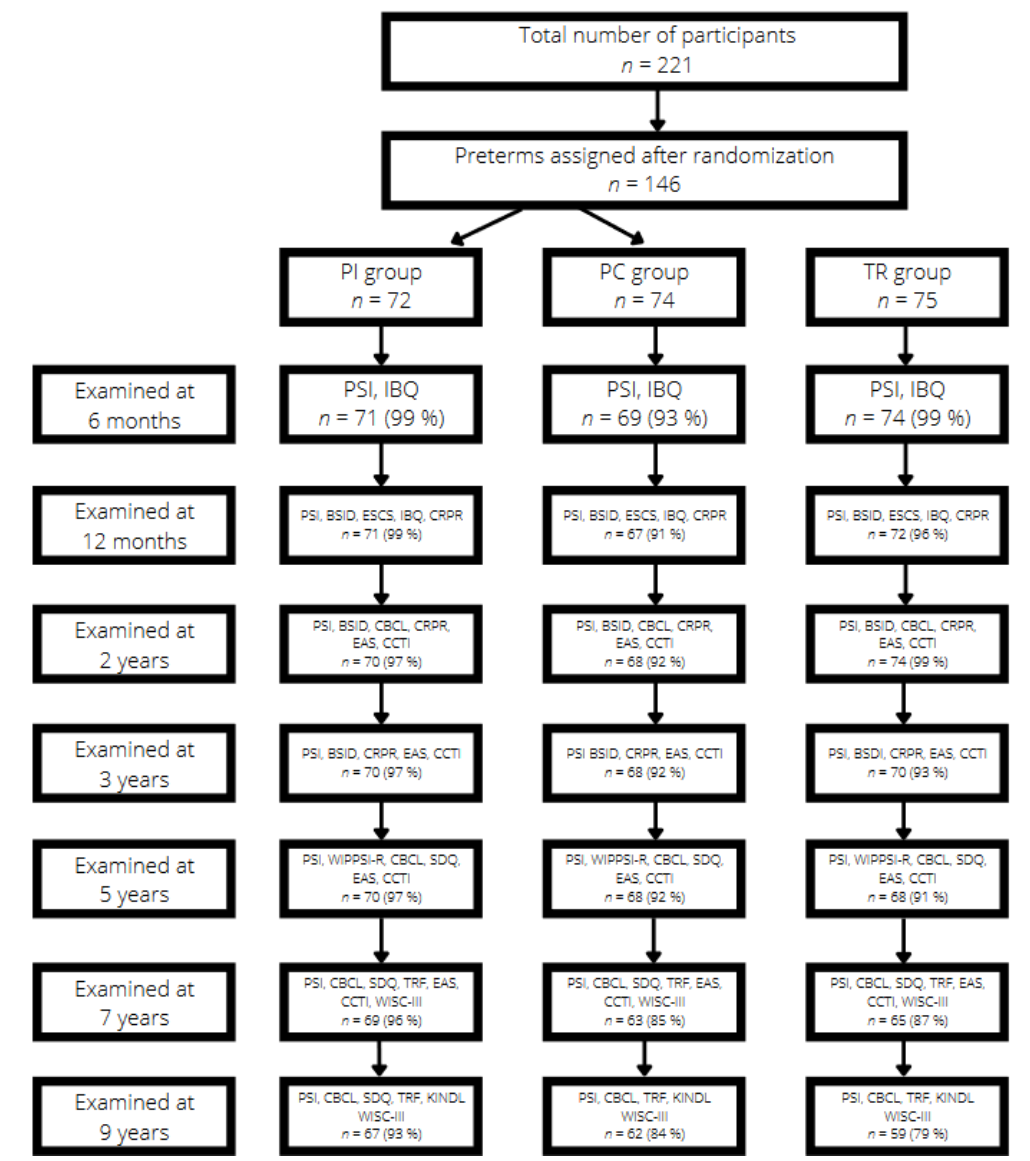
Figure 1. Study flow diagram from ages 6 months to 9 years. BSID = Bayley Scales of Infant Development; CBCL = Child Behavior Checklist; CCTI = Colorado Childhood Temperament In- ventory questionnaire; CRPR = Child Rearing Practice Report; EAS = Emotionality, Activity and Sociability questionnaire; ESCS = Early Social Communication Scales; IBQ = Infant Behavior Ques- tionnaire; PSI = Parenting Stress Index: KINDL = Questionnaire for measuring quality of life for children and adolescents; SDQ = Strengths and Difficulties Questionnaire; TRF = Teacher Report Form; WIPPSI-R = Wechsler Preschool Primary Scale of Intelligence; WISC- III = Wechsler Primary Intelligence Scale for Children.